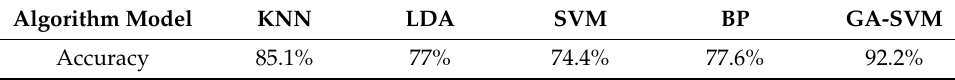
Table 5. Average accuracy of a commonly used classification model.